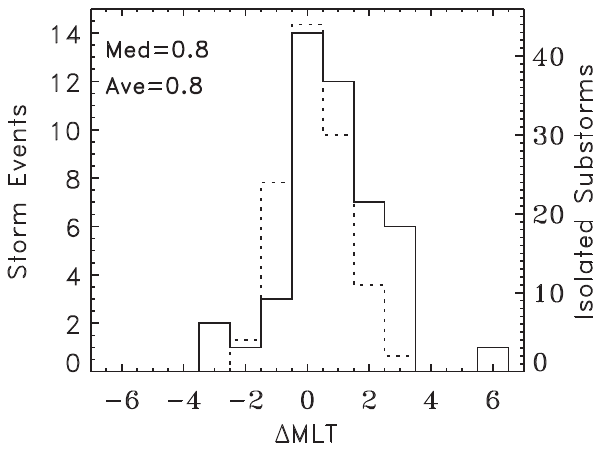
Fig. 10. Histograms of the differences in MLTs of the maximum expansions compared with the MLTs of onsets for the storm-time substorms (solid lines) and for the isolated substorms (dotted